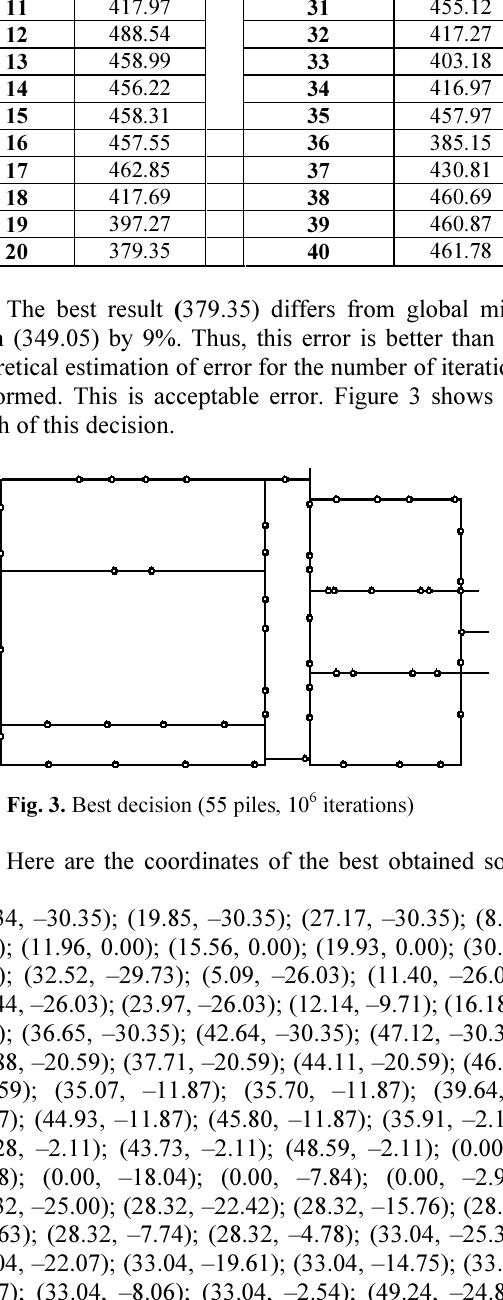
Table 10. SA results (55 piles, 1.000.000 iterations) Sample